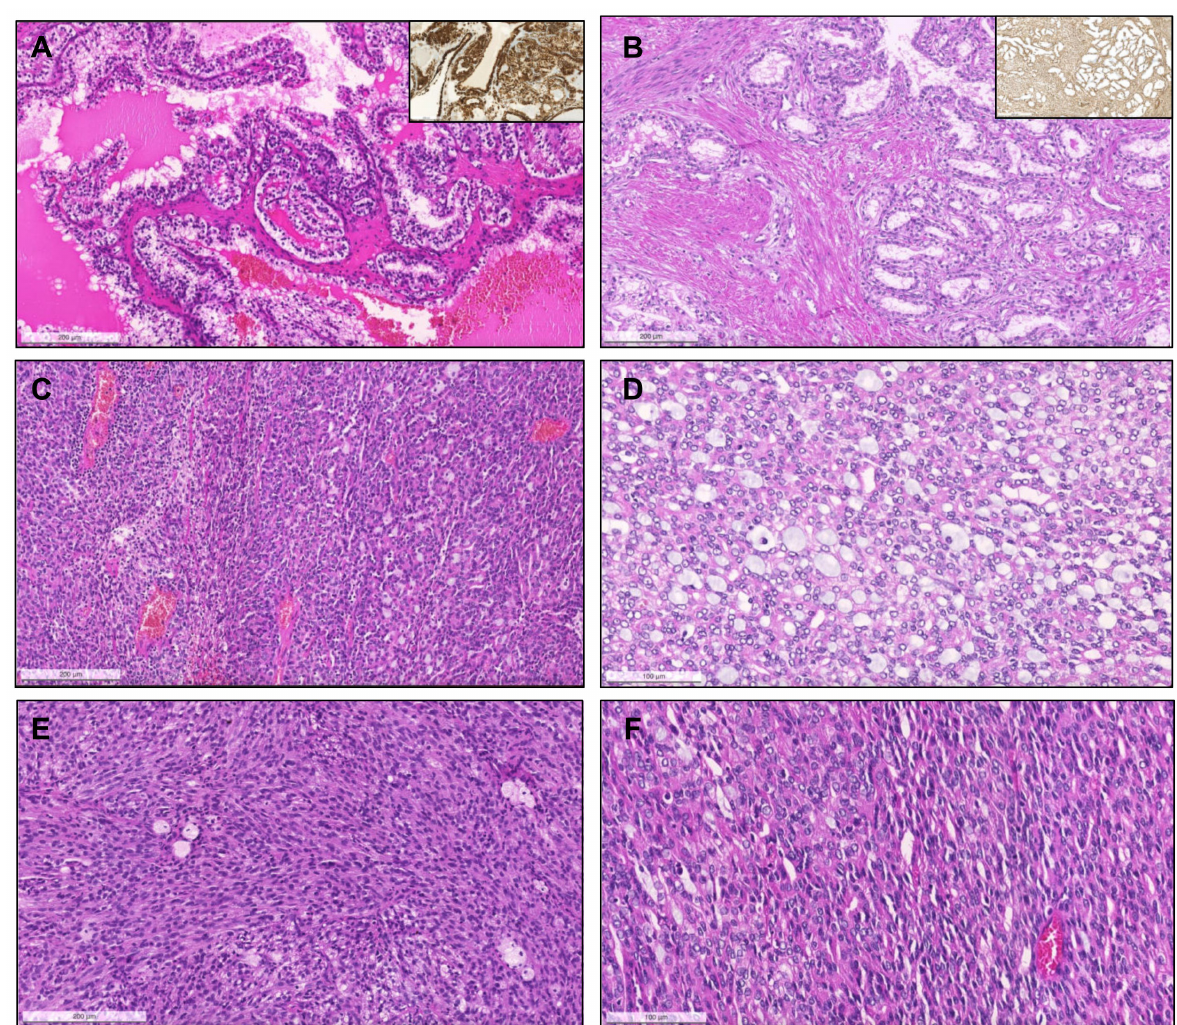
Figure 7. Clear cell papillary renal cell carcinoma, composed of papillae and tubulopapillary structures filled with clear cells, with small grade 1 nuclei, that show reversed polarity, distributed towards the apical pole of the cells. The tumors are diffusely positive for CK7 (inset, ( A ). Renal cell carcinoma with fibromyomatous stroma. Notice the remarkable smooth muscle fascicles surrounding and intersecting the tumor (positive for desmin, inset), which is composed mainly of groups of clear cells arranged in a tubule-papillary fashion ( B ). Mucinous tubular and spindle cell carcinoma. At low power ( C ), the transition between an area with compact tubular structures containing blue mucin (right) to an area with spindle/elongated cells is seen (left). In some cases, the tubular and mucinous features were remarkable, with the presence of mucin in the stroma and in the lumina of tubular structures ( D ), while in others the tumors were almost only composed of spindle cells, with elongated nuclei of low grade ( E ). Sometimes, the compact elongated tubules and stromal mucin are difficult to spot, only discernible at a higher power, resembling the solid pattern of pRCC ( F